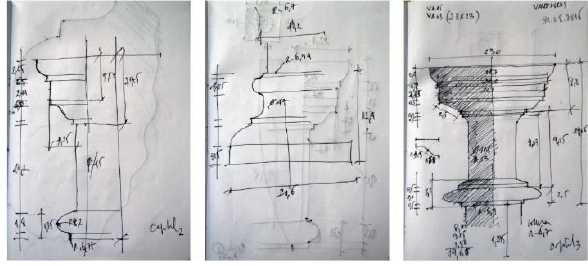
Figure 11. Direct observation drawings.